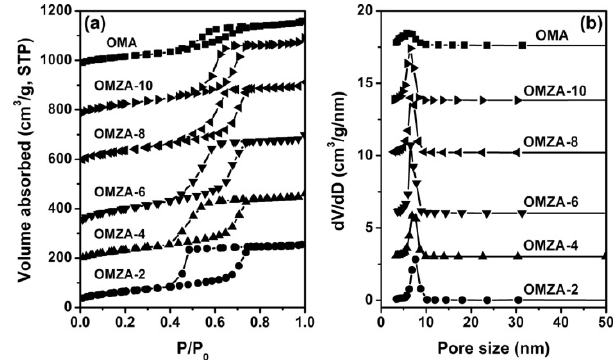
Figure 5. N 2 sorption isotherms ( a ) and pore size distribution curves ( b ) of samples OMZA-x and OMA. For clarity, in ( a ), the isotherms of OMZA-4, OMZA-6, OMZA-8, OMZA-10 and OMA are offset along the Y axis by 150, 300, 560, 750, and 950 cm 3 /g, respectively. In ( b ), the Y axis values are increased by 3.0, 6.0, 10.2, 13.8, and 17.8 cm 3 /g, respectively.